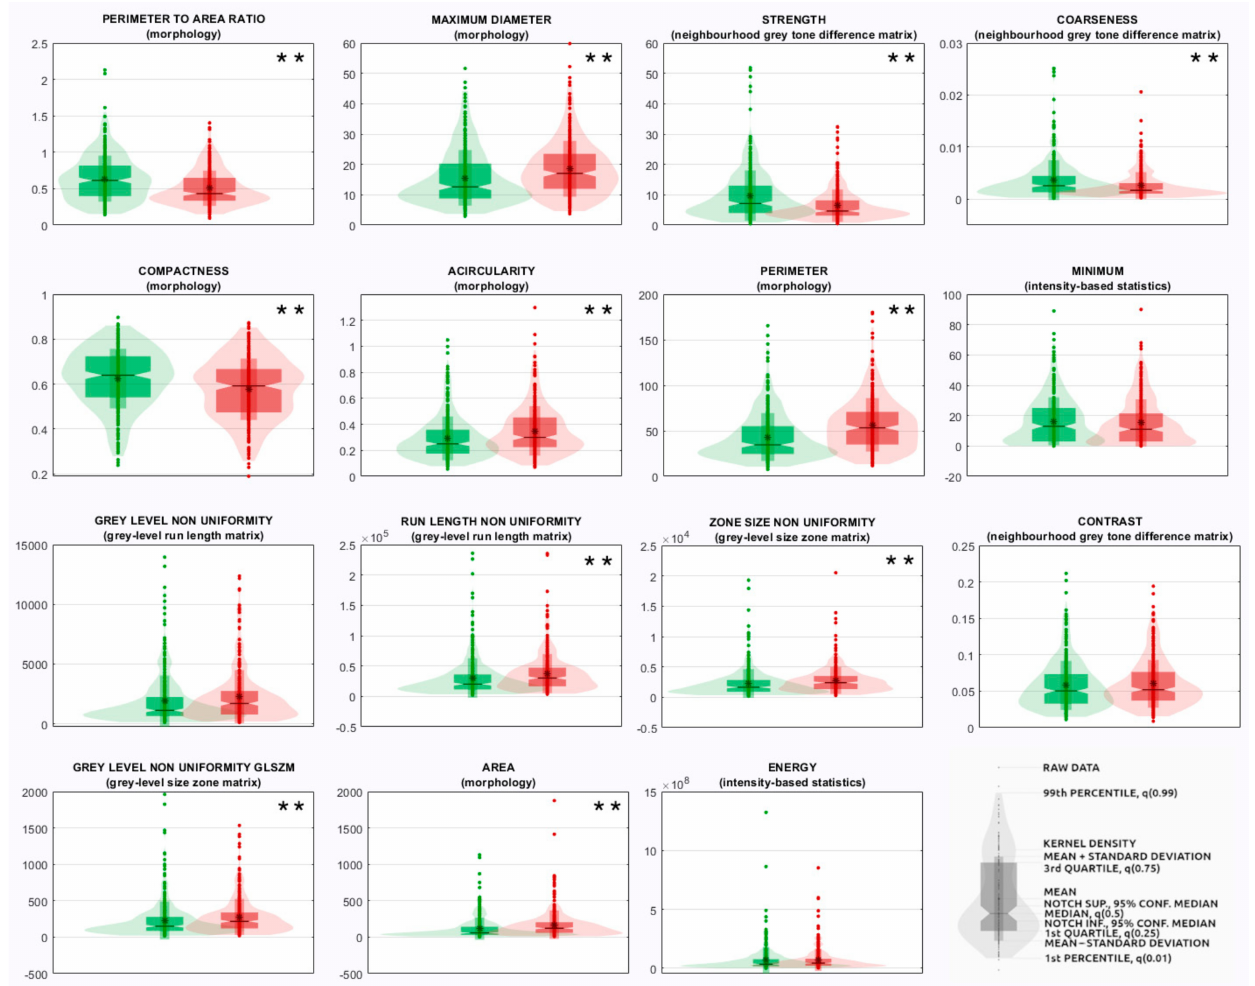
Figure 2. Ensemble of support vector machines: violin plots and boxplots of the most relevant radiomic predictors ranked from 1 to 15. Green: benign class. Red: malignant class. ** denotes a statistical significance at 0.005 (adjusted with Bonferroni–Holm